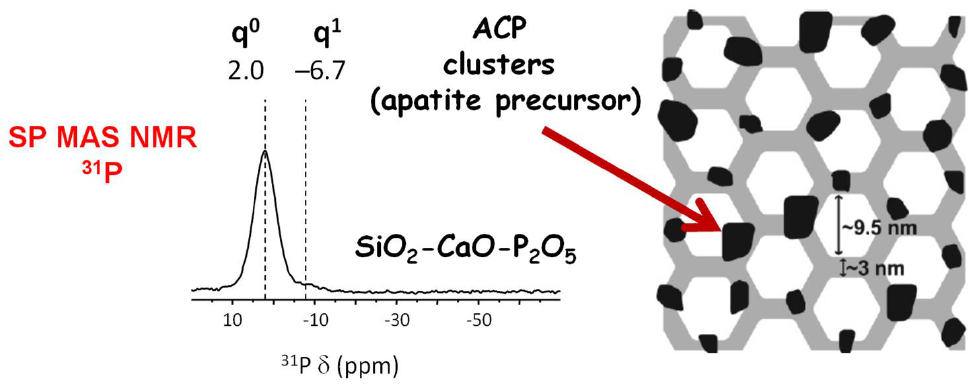
Figure 2. Structural characteristics of MBG. Solid-state nuclear magnetic resonance (NMR) studies